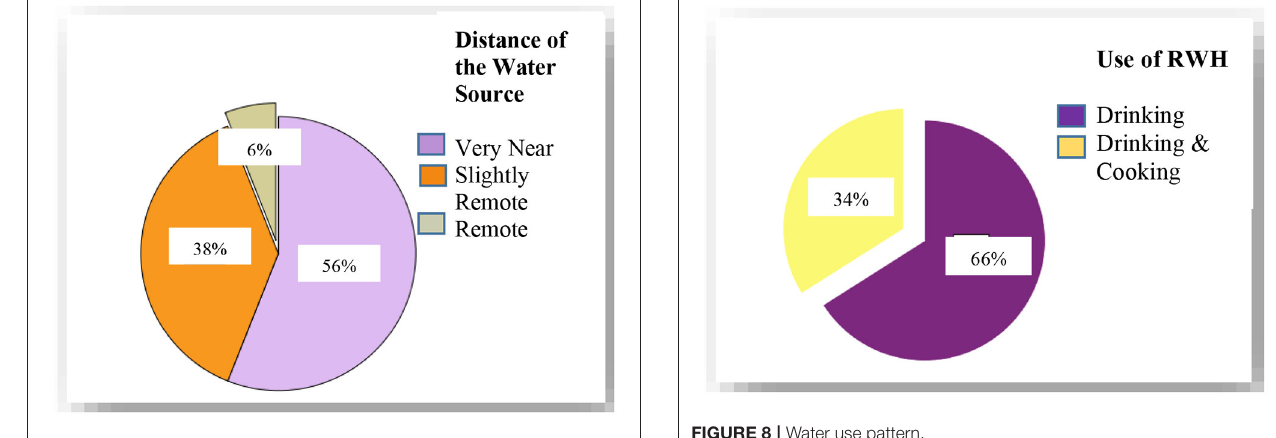
FIGURE 7 | Distance of the nearby water source.